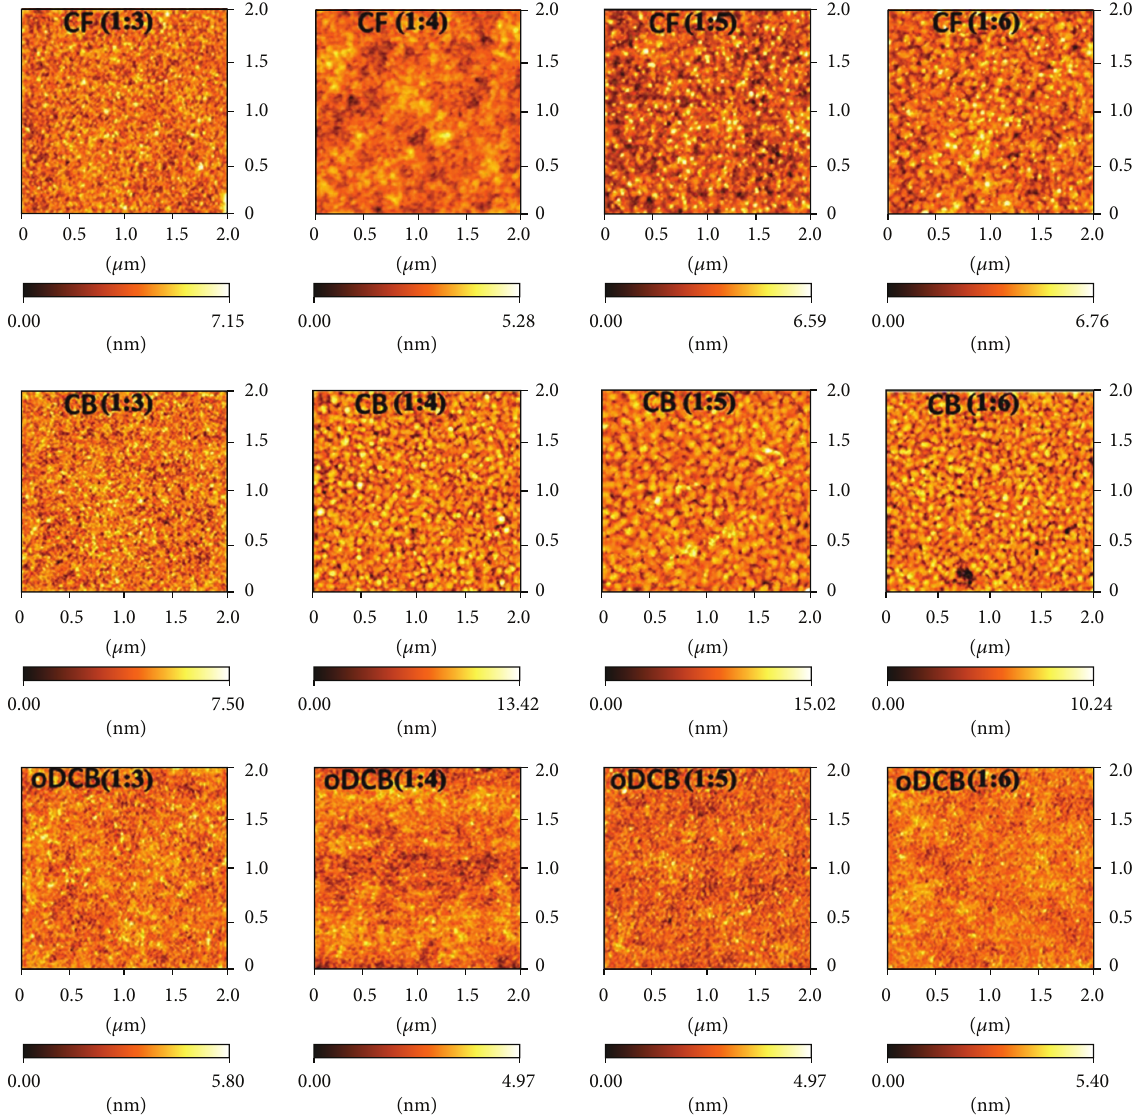
Figure 3: AFM images of the PCDTBT: PC 71 BM films prepared by using organic solvents of chloroform (1wt%), chlorobenzene (2 wt%), and o-dichlorobenzene (3wt%): blend ratio of PCDTBT and PC 71 BM was varied from 1:3 to 1:6.